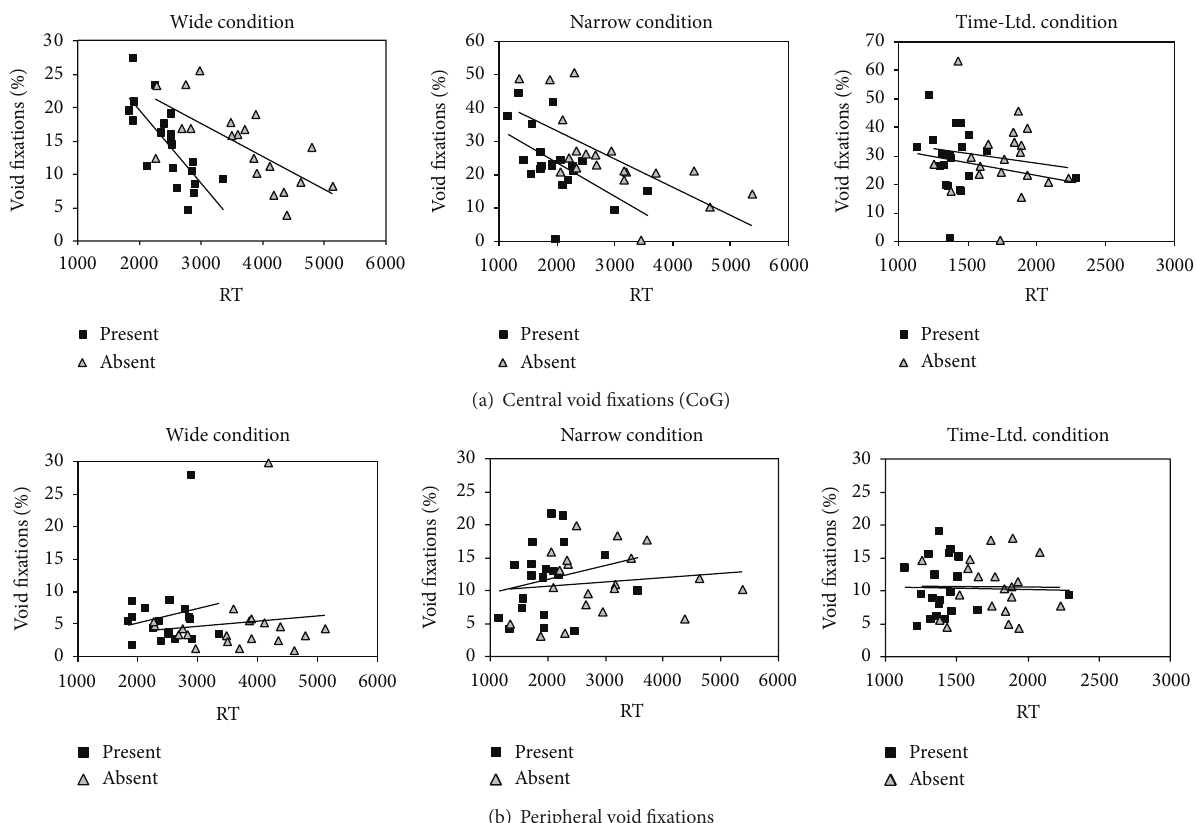
Figure 2: Effects of CoG fixations on search performance (RT), Experiment 1. Mean search times as a function of the proportion of void fixations in Experiment 1, depicted separately for each blocked condition (wide, narrow, and time-limited). Larger proportions of central void fixations were associated with shorter RT, both on target absent trials (black squares) and target present trials (grey triangles). Error bars depict ± 1 SEM and may be smaller than the plotting